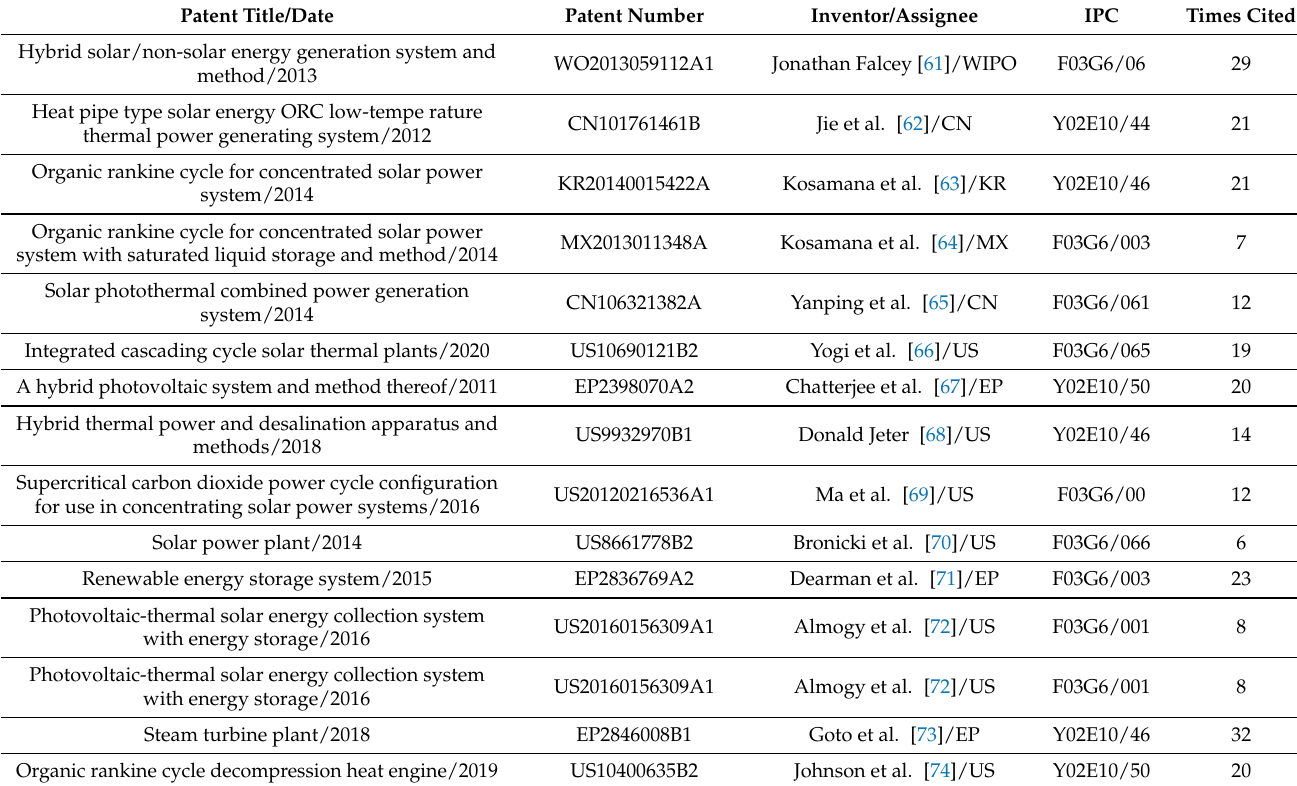
Table 4. Patent updates for solar energy technologies in ORC